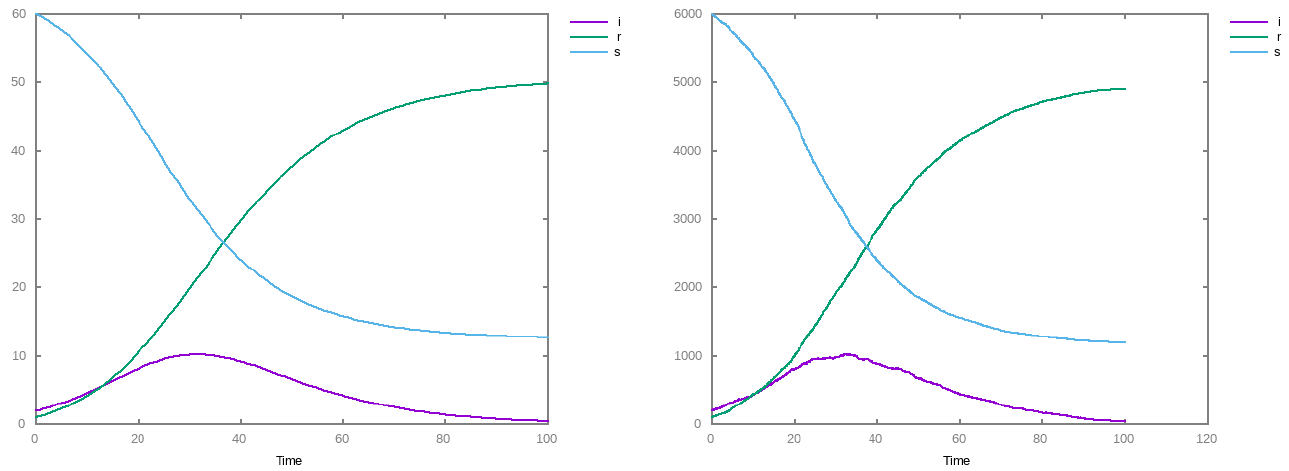
Figure 1. Simulation of susceptibles (S), infectives (I) and recovereds (R) (SIR) model. ( Left ) deterministic. ( Right ) Stochastic simulation algorithm (SSA); only the average values are